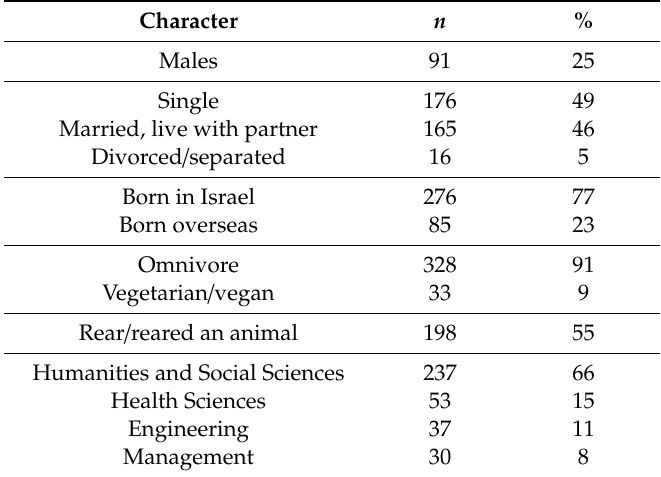
Table 1. Description of sample characteristics ( n =